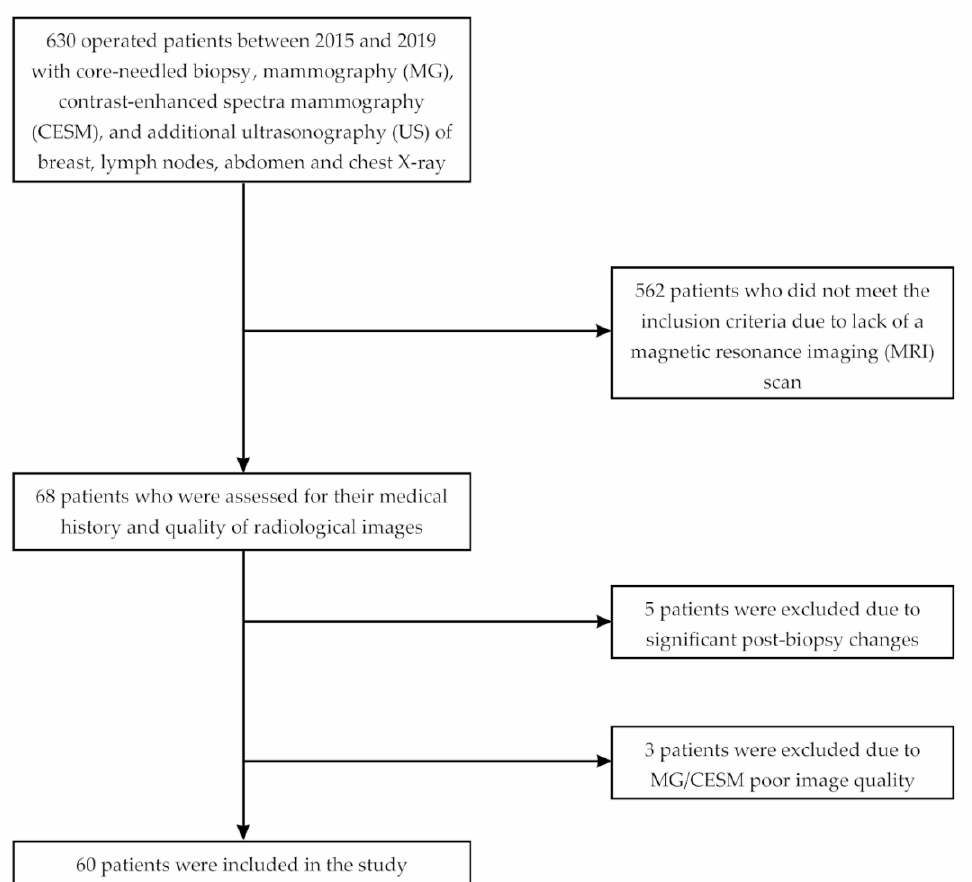
Figure 1. Flowchart of the study.